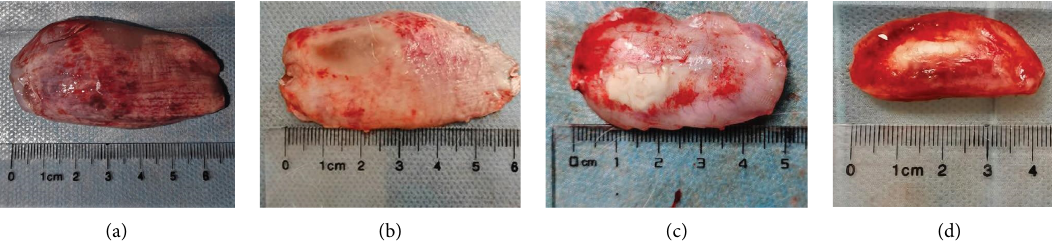
Figure 1: Necrotic lesions in the muscle of the hindlimbs of envenomed rabbits (photographs taken by Xue-Ling Lu and Jun-Rong Zhu).